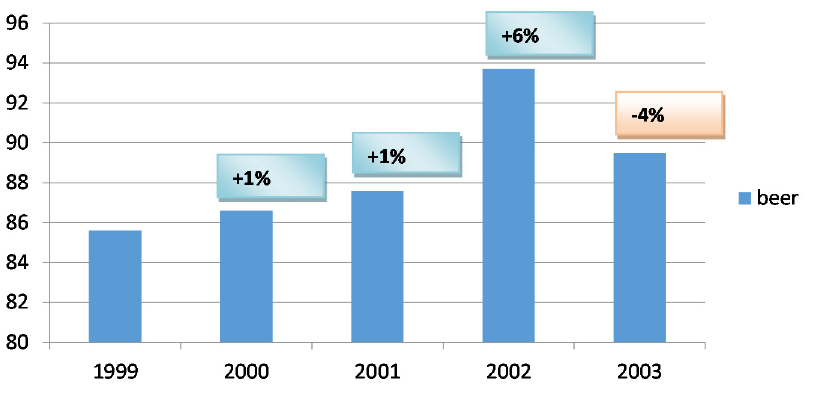
Figure 1. Beer sales from 1999 to 2003. Source: own calculations based on data from the Slovak Association of Beer and Malt Producers